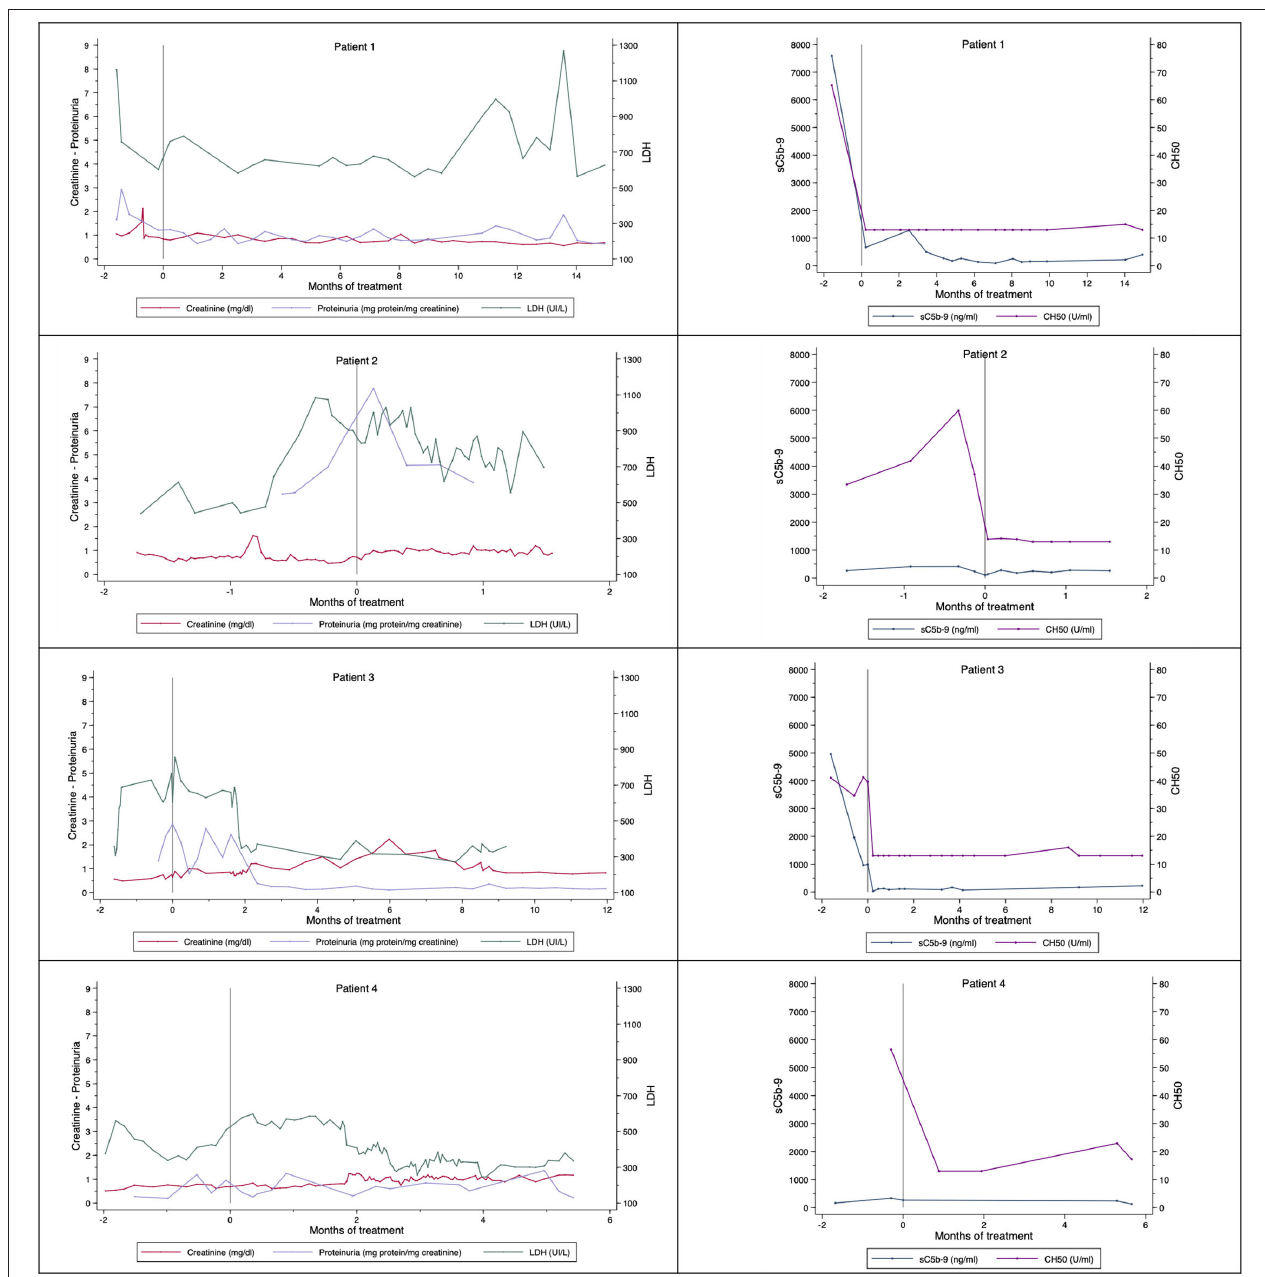
FIGURE 1 | Changes in creatinine, proteinuria, LDH, and markers of eculizumab-induced complement blockade, sC5b-9 and CH50. Month 0 represents the start of treatment with eculizumab. Reference values: sC5b-9 < 303ng/ml; CH50 < 34 U/ml; LDH 0-248 UI/L. CH50, total complement hemolytic activity; LDH, lactate dehydrogenase; sC5b-9, soluble membrane attack